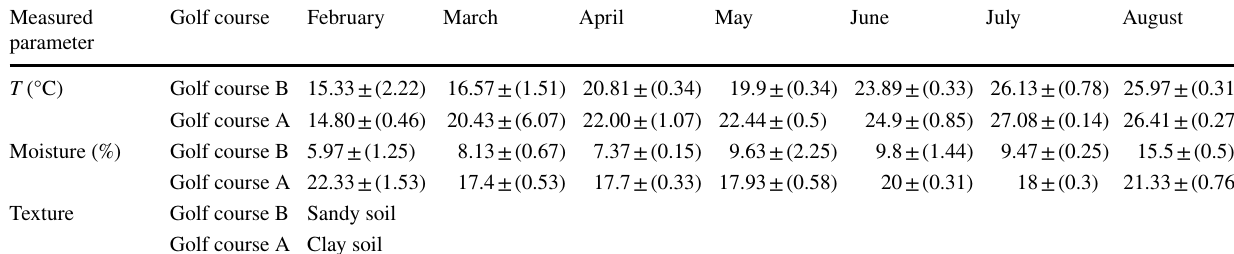
Fig. 3 Monthly variations of pH in soil sampled in golf course A [soil irrigated with